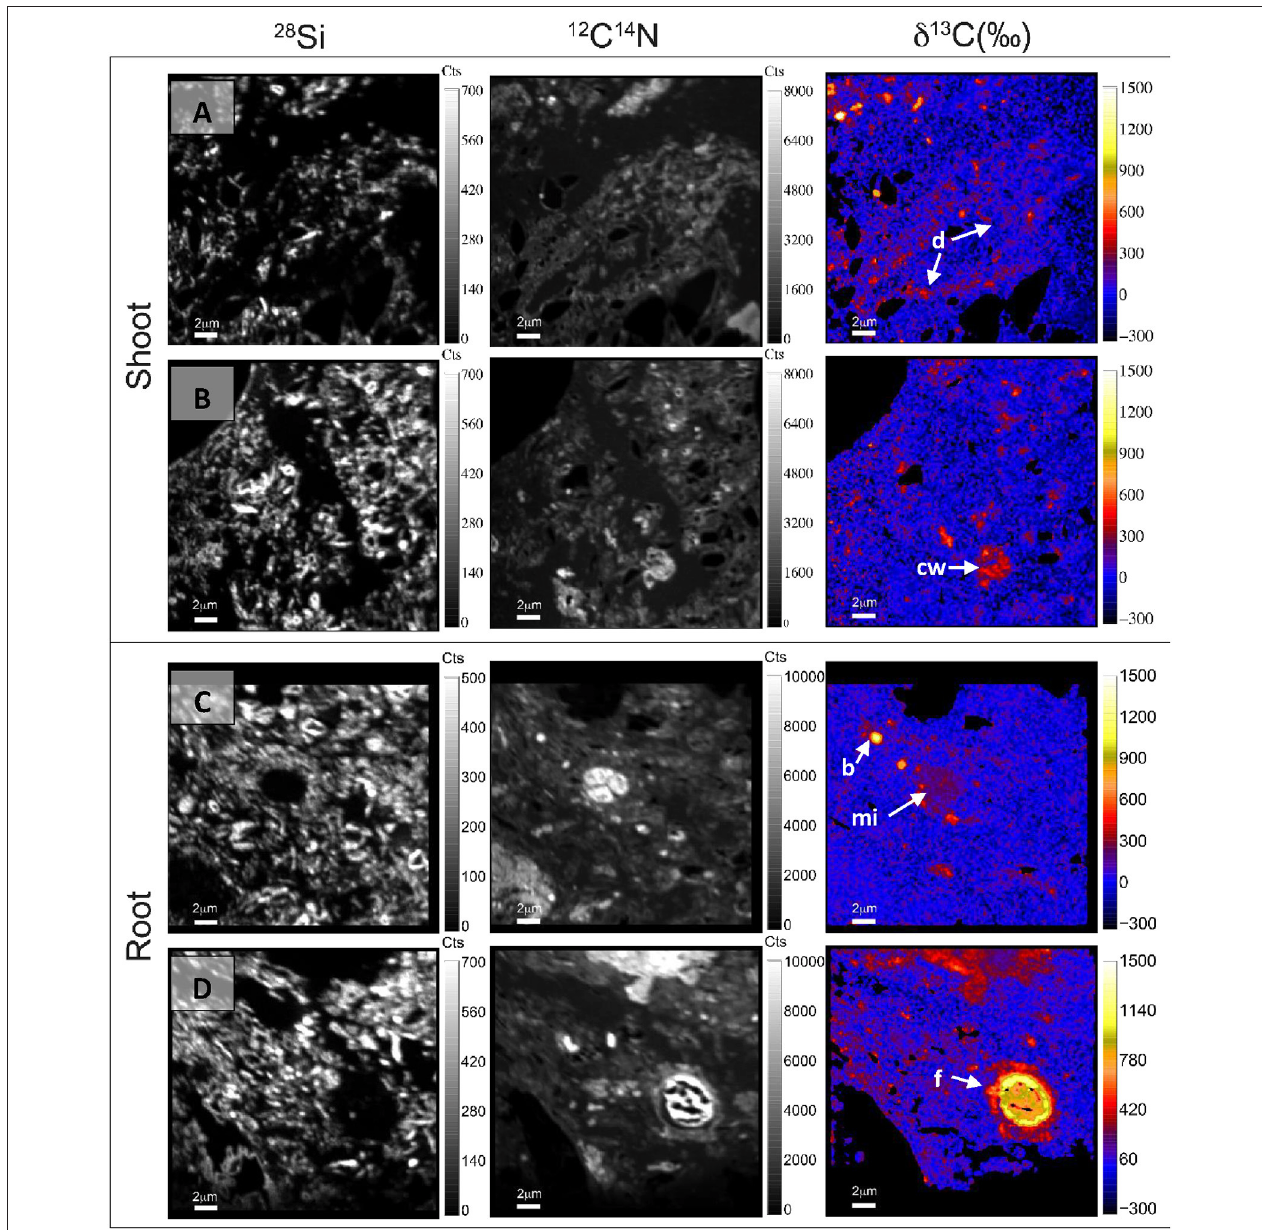
FIGURE 6 | NanoSIMS maps of 28 Si − , 12 C 14 N − , and δ 13 C illustrating the integration of labeled organic structures (both plant tissues and microorganisms) inside organo-mineral aggregates, after 54 weeks of experiment, for both Cast-Shoot (A,B) and Cast-Root (C,D) . b, bacteria; cw, cell wall; d, “diffused” labeling; f, fungus; mi, microorganism (bacteria or